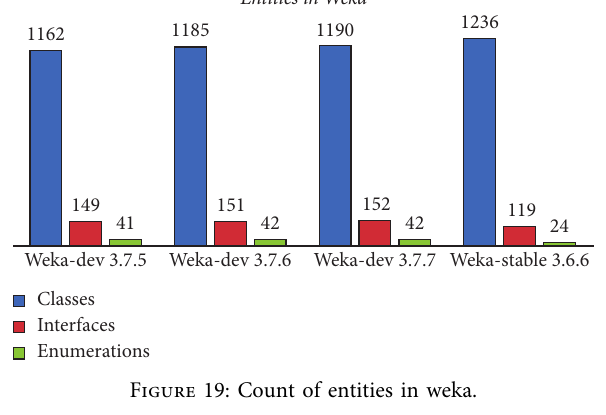
Figure 19: Count of entities in weka.